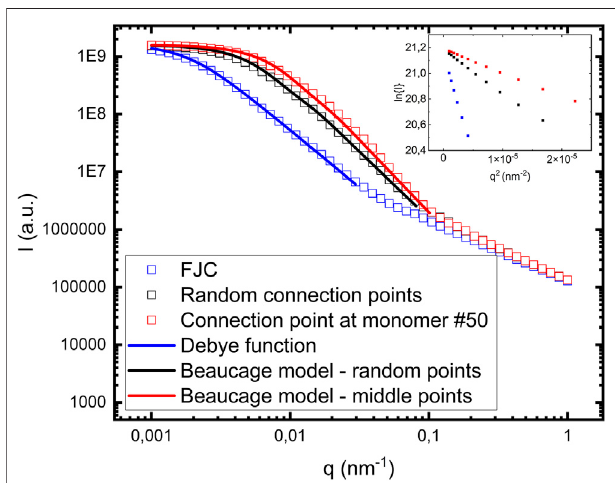
FIGURE 4 | Comparison between different calculated cluster form factors: i) FJC model (blue empty squares) , ii) random connection points (black empty squares) , and iii) each fi bril having one connection point at monomer#50 (redemptysquares) .The bluesolidline ini)correspond toa model calculation using the Debyefunction( Eq. 6 ). The black and the red solidlines correspondtomodelcalculationsusingtheBeaucagemodel( Eqs2 and 3 ). R g decreasesand d increasesfromi)toiii).TheinsetshowsGuinierplots ln(I) vs q 2 for the low q data, from which R g also can be